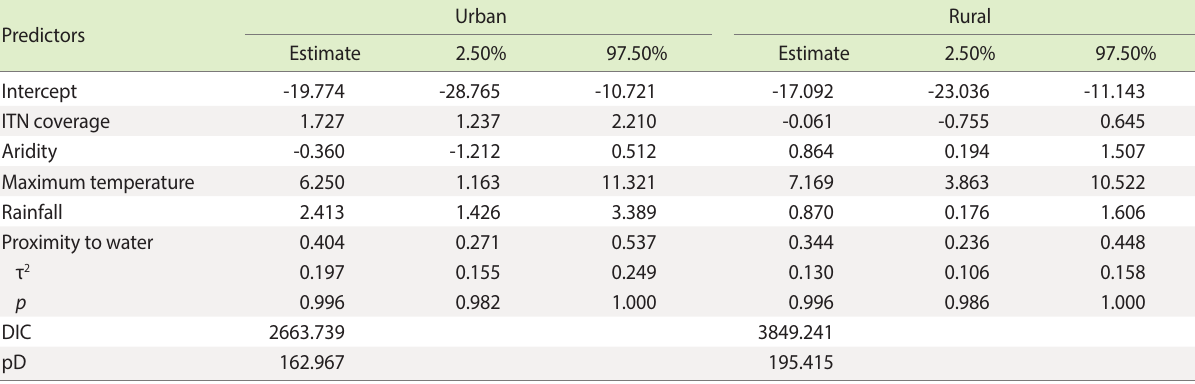
Table 6. Bayesian hierarchical regression of the predictors of malaria prevalence in rural and urban populations